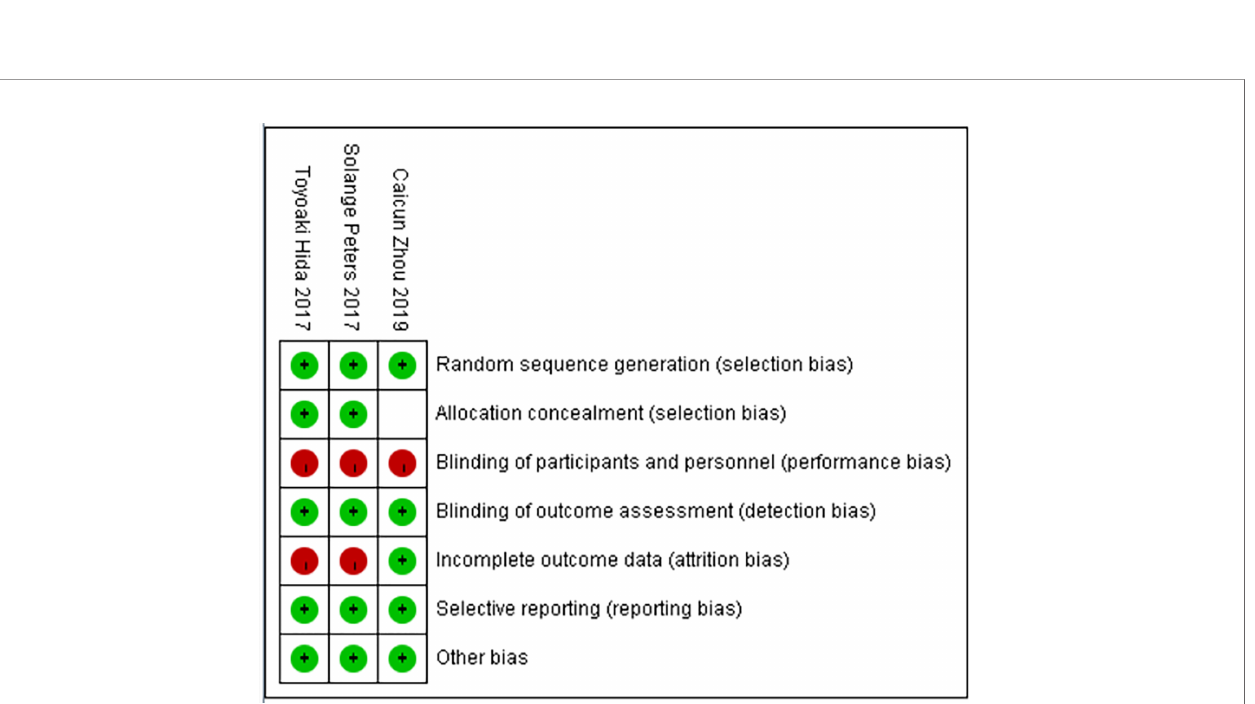
FIGURE 3 | Summary of risk of bias in included